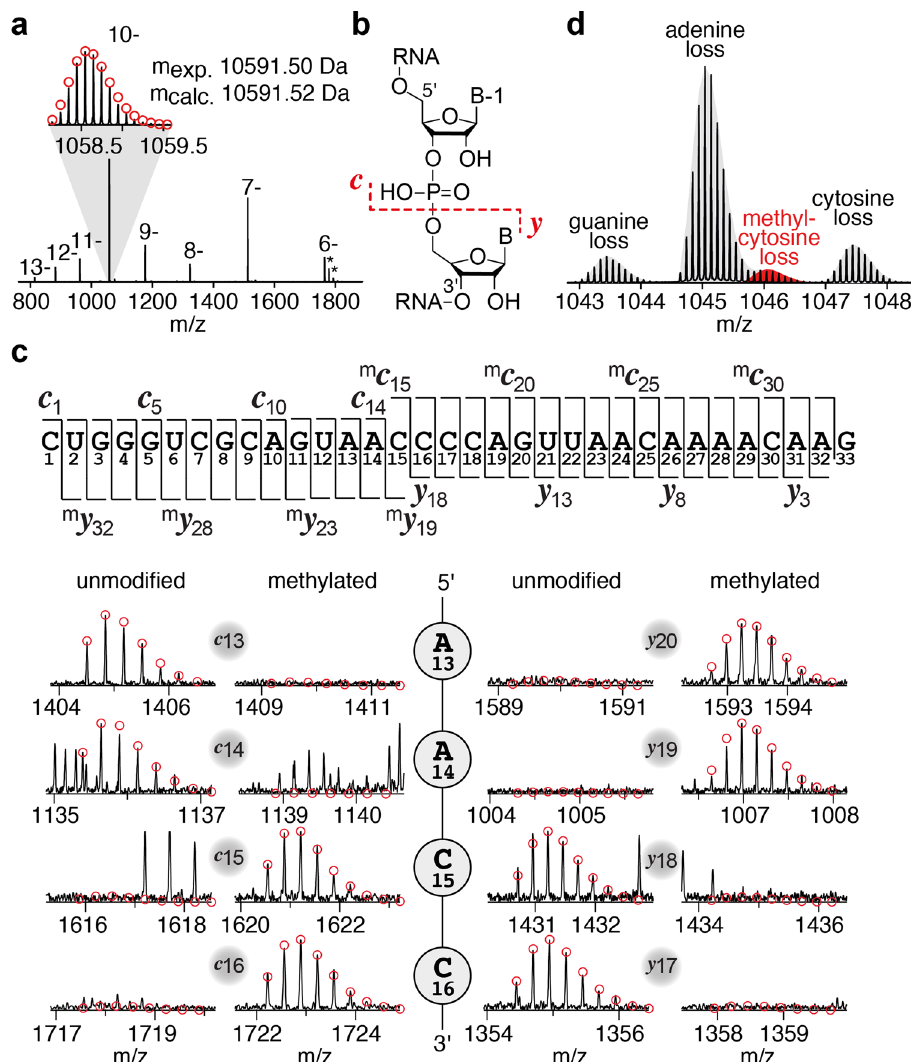
Fig. 3 FT-ICR mass spectrometric characterization of the methylated RNA product. a ESI mass spectrum of the 33 nt m 3 C Tt preQ 1 -I RNA; the inset shows the isotopically resolved signal of the (M – 10H) 10- ions; asterisks indicate piperidine RNA adducts. b Collisionally activated dissociation (CAD) of (M – nH) n – ions of RNA in the collision cell produces c and y fragment ions from RNA backbone cleavage. c Fragment-ion map illustrating sequence coverage from CAD of the methylated Tt preQ 1 -I RNA. The numbering of c and y fragments starts from the 5 ’ and 3 ’ terminus, respectively (top). MS signals of unmodi fi ed and methylated c 13 , c 14 , c 15 , c 16 , and complementary y 20 , y 19 , y 18 , y 17 fragments from CAD of (M − 7H) 7 − and (M – 10H) 10 − ions reveal the site of methylation (C15); the calculated isotopic pro fi les for unmodi fi ed and singly methylated RNA are indicated by red open circles. d Loss of methylated cytosine (red) in spectra from collisionally activated dissociation (CAD) of (M – 10H) 10- ions of RNA is direct evidence for C nucleobase methylation; the 1:3 ratio of m 3 C/C nucleobase losses is consistent with destabilization of the glycosidic bond as a result of methylation at the N3